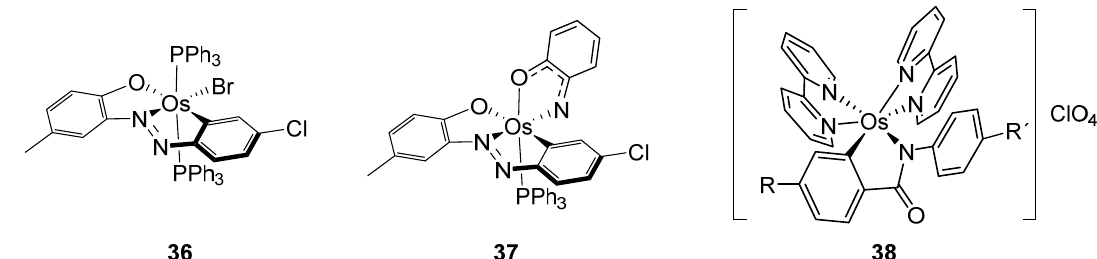
Figure 9. Cyclometalated osmium complexes obtained by C–H bond activation of phenols and hydroxamic acids.